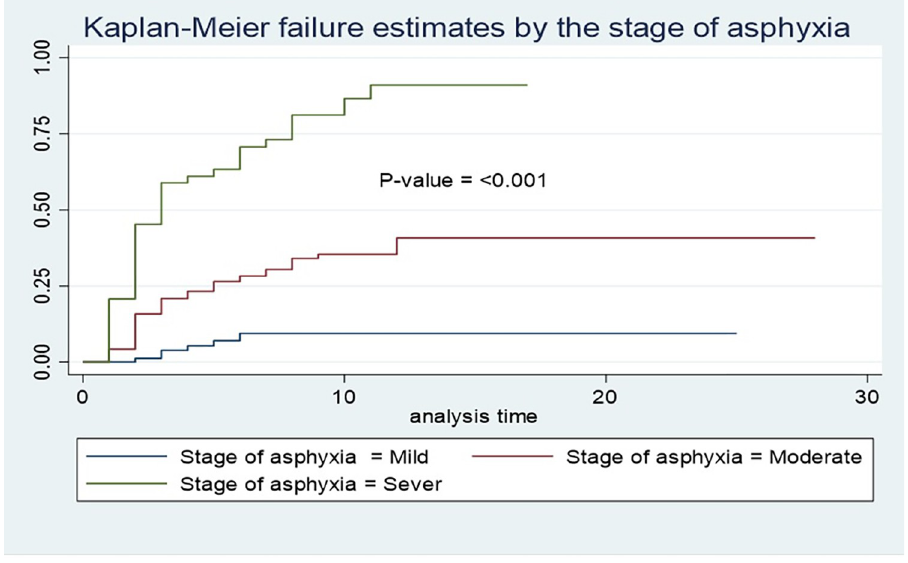
Fig 6. Kaplan-Meier failure curves to compare the mortality pattern of asphyxiated neonates based on the stage of asphyxia in DCSH, Amhara region, Northeast Ethiopia (N =